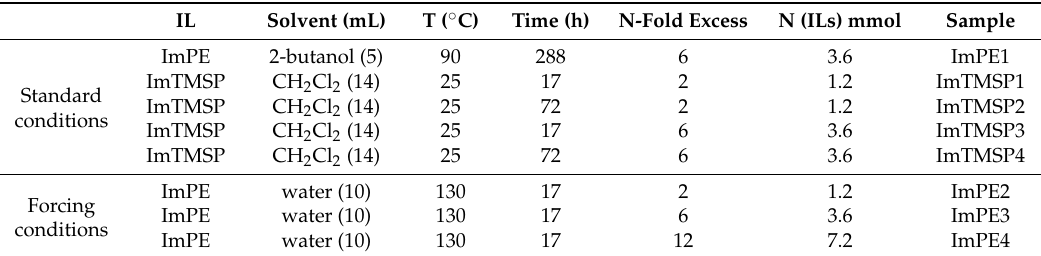
Table 1. Standard and forcing conditions for grafting the γ -alumina powders with organophosphonate imidazolium-based ionic liquids (ILs).